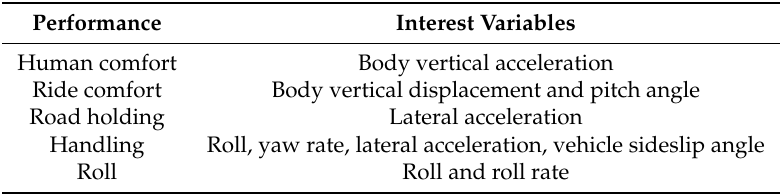
Table 11. Performances to be evaluated in full vehicle model